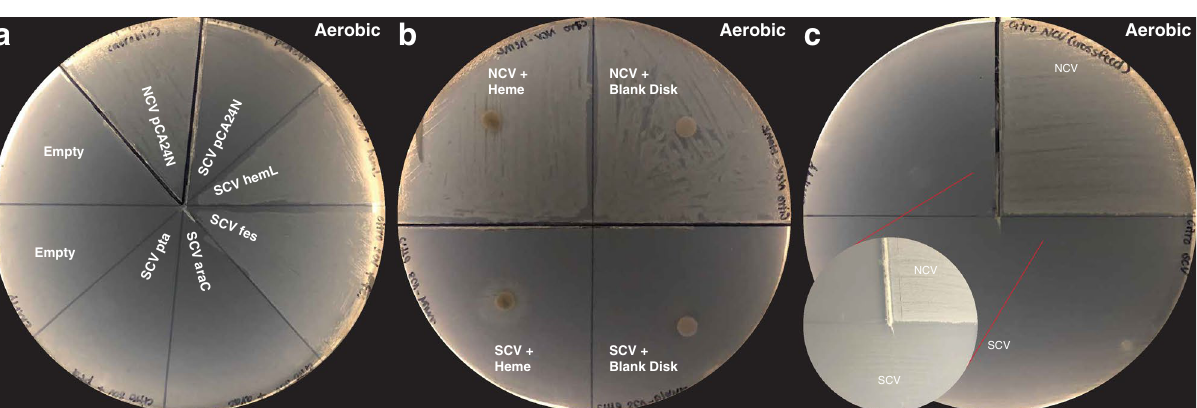
Figure 3. Heme biosynthesis along with iron availability lesion as cause of small colony phenotype in Citrobacter freundii isolated from urinary tract infection. Genomic sequencing of the paired NCV and SCV isolates revealed genomic lesions in araC , fdnG , fes , hemL , pta , and in the intergenic region upstream of the hemF gene. ( a ) Genetic rescue with fes and hemL rescued normal growth from the Citrobacter freundii SCV. ( b ) Chemical rescue with heme restored normal growth in Citrobacter freundii SCV. ( c ) Cross-feeding from Citrobacter freundii NCV partially restores growth of SCV, consistent with a diffusible factor required for growth. All plates in this figure were incubated under aerobic